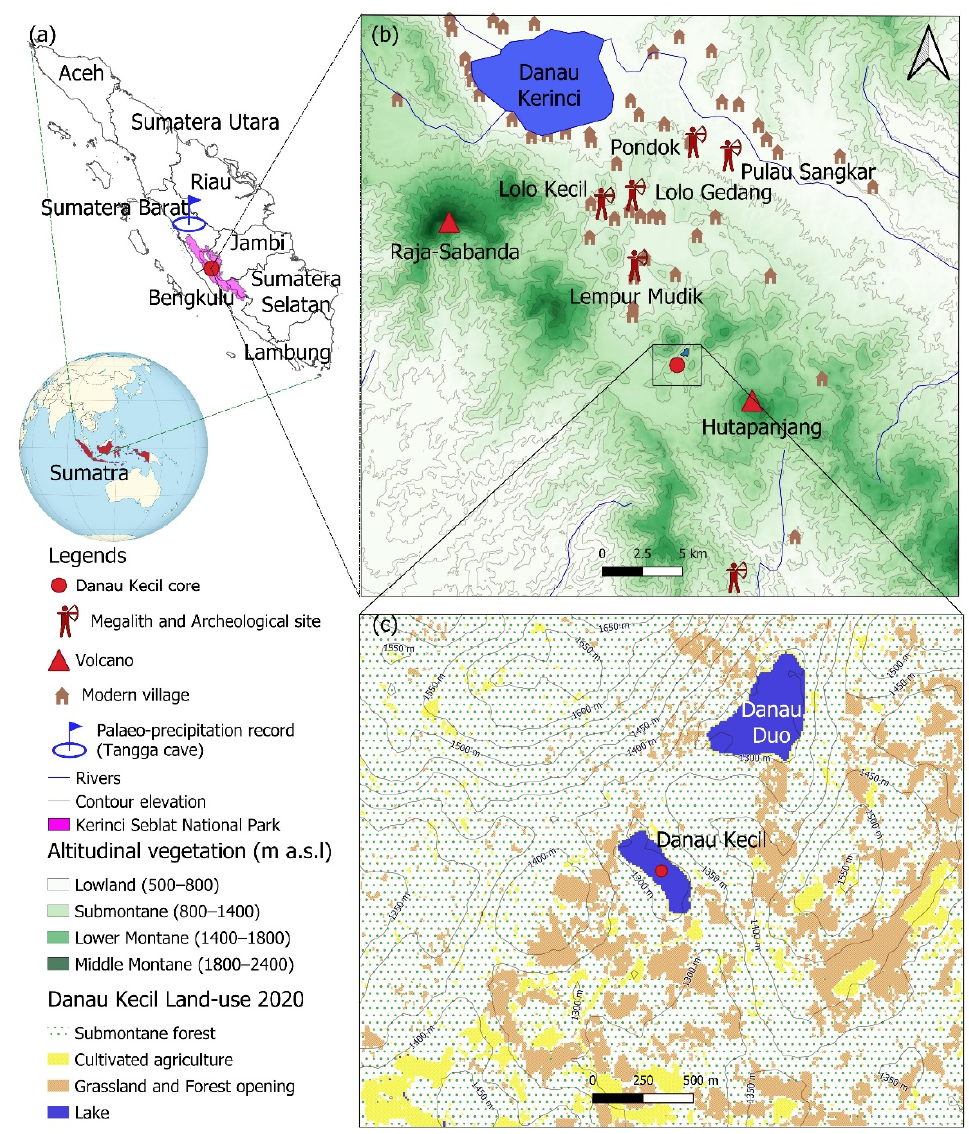
Figure 1. Map of the study area. ( a ) Location of the studied region, pink area of the Kerinci Seblat National Park (KSNP) in Sumatra. The red dot shows the location of the study site (Danau Kecil) in the KSNP and the paleo-precipitation record in the Tangga Cave [19]. ( b ) The study site: The Danau Kecil core is marked by the red dot. The red triangles represent unactive volcanoes. Information on the location of archeological sites and modern villages was derived from Bonatz [5] and Aziz [20]. Data source for the digital elevation model: ASTER GDEM Version 2 from METI and NASA, altitudinal vegetation types were adapted from Laumonier [15], and the location of volcanoes were from the Global Volcanism Program [21]-https://volcano.si.edu/ (accessed on 24 August 2021). ( c ) Land-use map around Danau Kecil was derived from Sentinel satellite images (USGS database, https://earthexplorer.usgs.gov; 2020). Dot areas indicate submontane forest, orange areas indicate grassland and open forest; yellow areas indicate agricultural cultivated